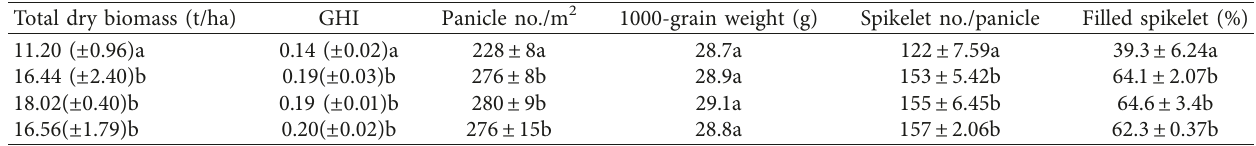
Table 3: Total dry biomass weight, grain harvest index (GHI), panicle number/m 2 , 1000-grain weight, spikelet number per panicle, and percentage of filled spikelets per panicle of red rice variety (MRM 16) grown in pot culture conditions as affected by different treatments.